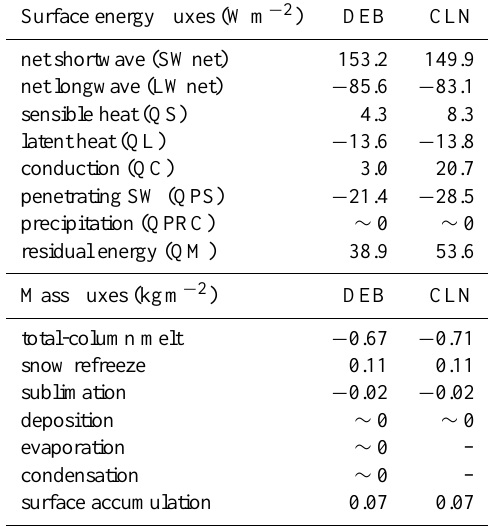
Table 4. Mean glacier surface-energy and climatic-mass